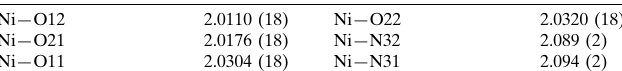
Selected bond lengths (A˚